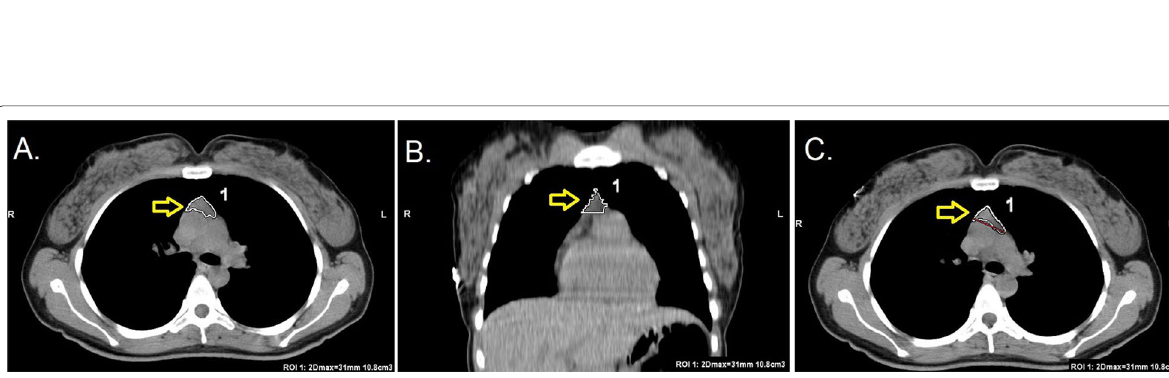
Table 1 Summary of the patients demographic data and CT measurements